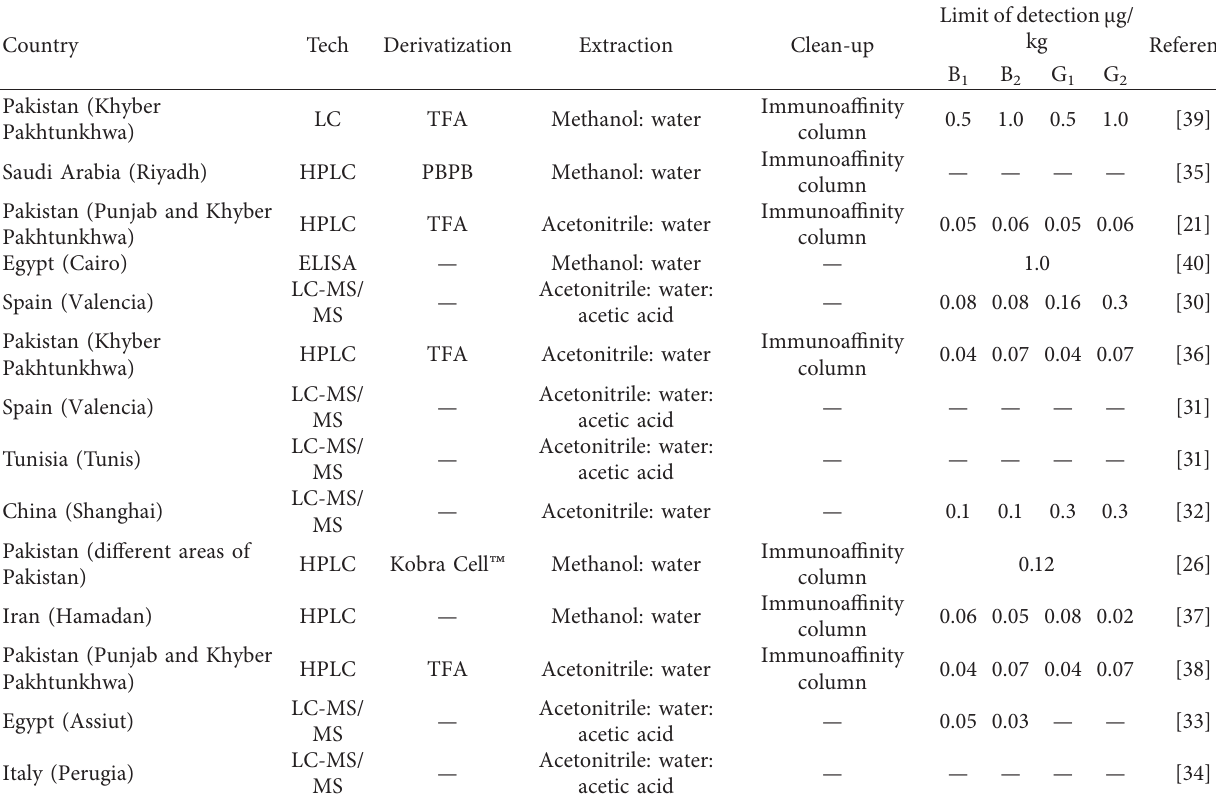
Table 1: Analytical procedure for aflatoxins determination in date palm